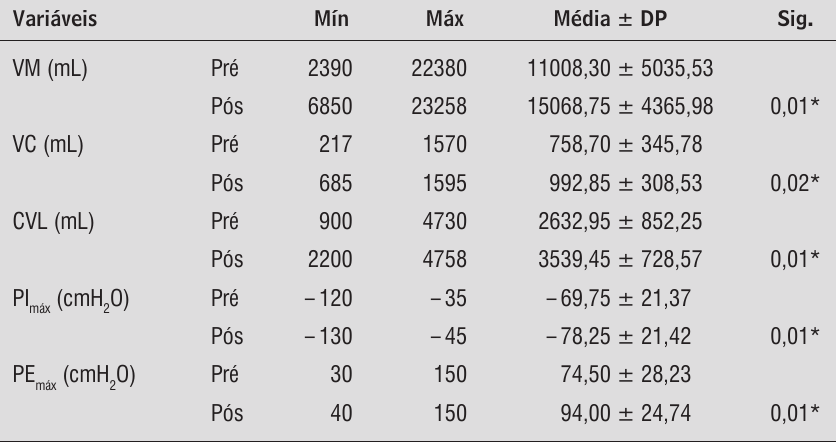
Tabela 3 - Apresentação da média, do desvio-padrão (DP) e do valor mínimo e máximo para as variáveis após a realização do programa de